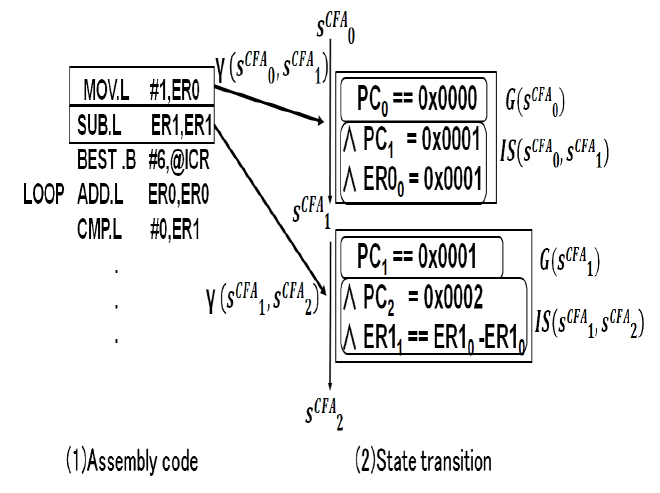
Figure 2. State transition of assembly